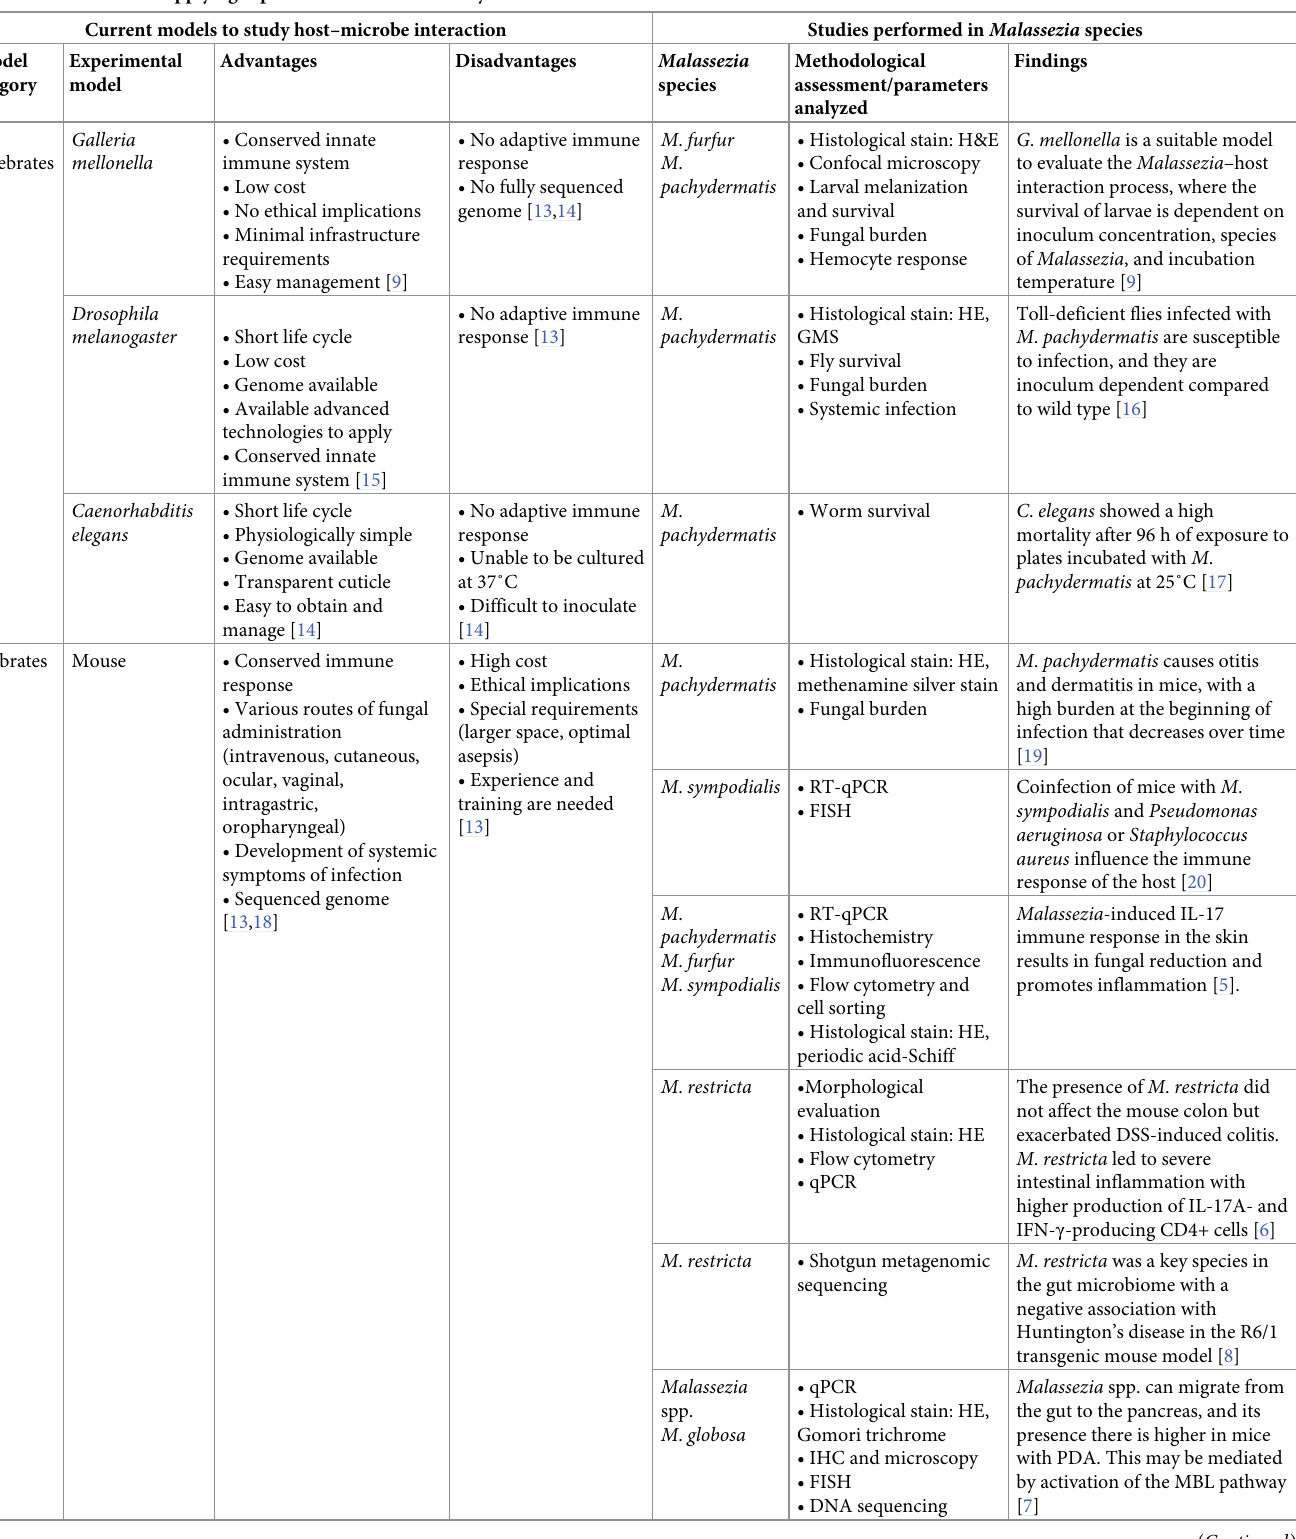
Table 1. Different studies applying experimental models to study Malassezia –host interactions. Current models to study host–microbe